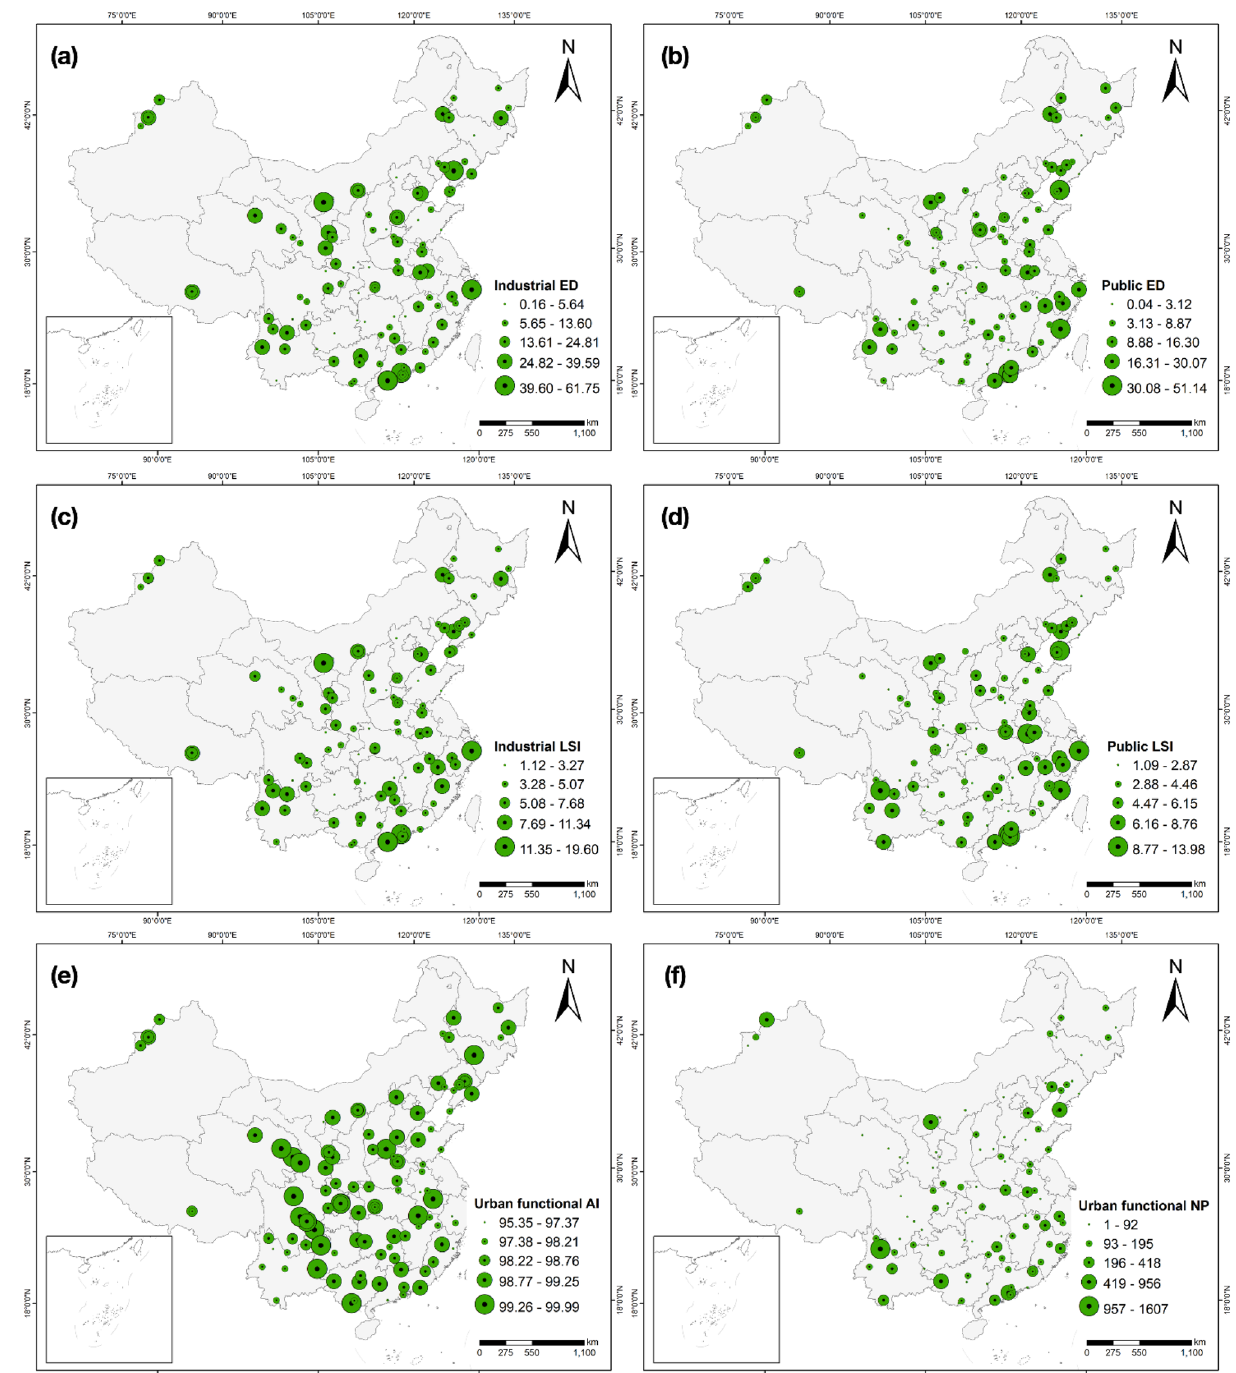
Figure 5. Urban functional fragmentation of each air station. ( a ) Industrial ED; ( b ) Public ED; ( c ) Industrial LSI; ( d ) Public LSI; ( e ) Urban functional AI; ( f ) Urban functional NP. The maps are performed using ArcGIS Pro software (version 2.7, https:// www. esri. com/ en- us/ arcgis/ produ cts/ arcgis- pro/ overv